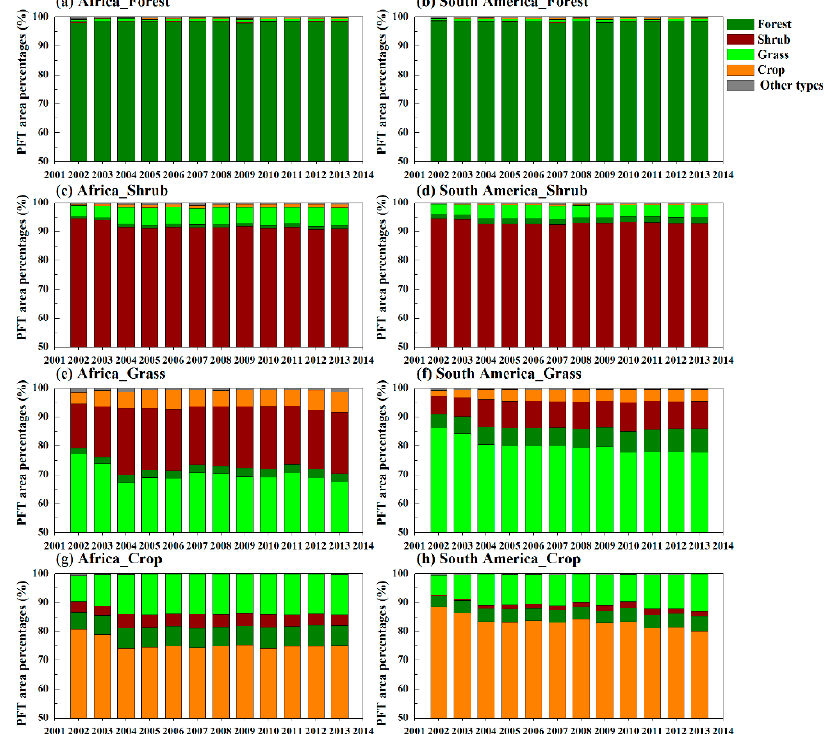
Figure 6. Land cover transitions (%) (forest: ( a , b ); shrub: ( c , d ); grass: ( e , f ); crop: ( g , h )) for high-density regions (individual vegetation type covered more than 80%) from 2001-2013 in Africa or South America in which pixels were not burned over the entire 13 years.